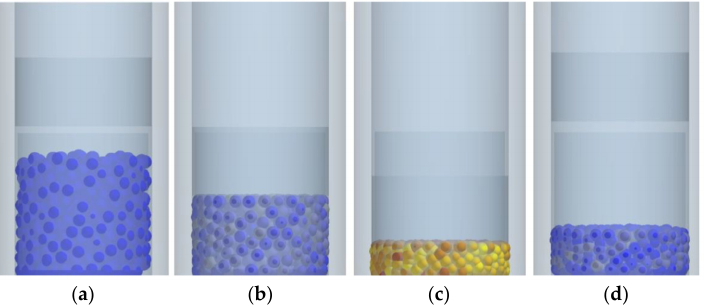
Figure 3. Simulation of the Young’s modulus determination for the compacted calcium hydroxide mixture: ( a ) material in the matrix without load; ( b ) material in the matrix partially loaded; ( c ) material in the matrix fully loaded; ( d ) material in the matrix unloaded. Table 1. Compaction characteristics of calcium hydroxide and mixture based on copper ore concen- trate. Compaction Coefficient